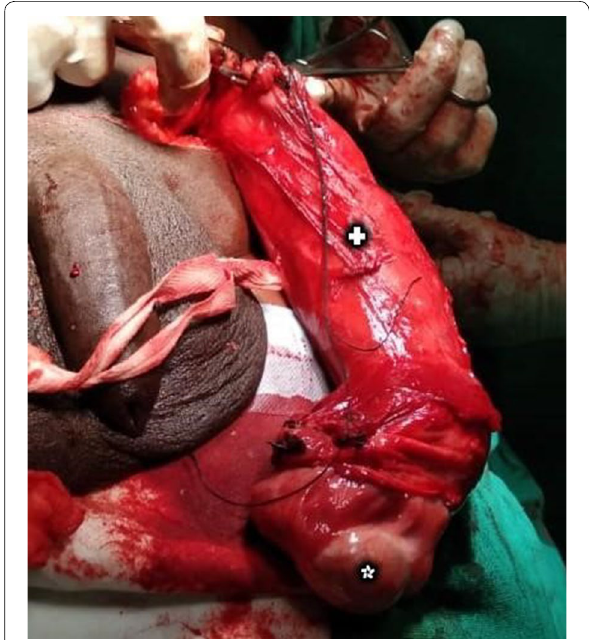
Fig. 1 Clinical intraoperative photograph showing diffusely thickened spermatic cord ( testis (*)